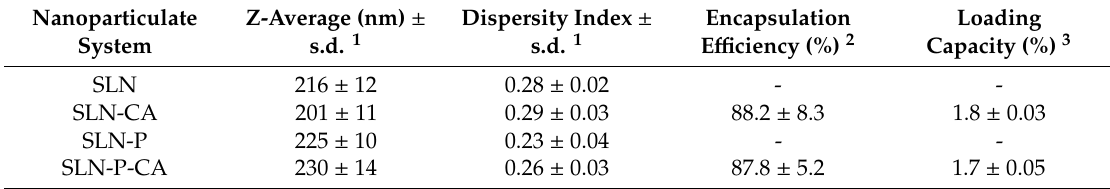
Figure 2. X-ray scattering profile for SLN (blue) and SLN-CA (red) samples. The SLN sample has been Table 2. Size distribution and encapsulation parameters of the indicated nanoparticulate measured only up to Q = 3.5 nm − 1 , so that the third order is not observable. Experiments were performed at Diamond Light Source (UK).